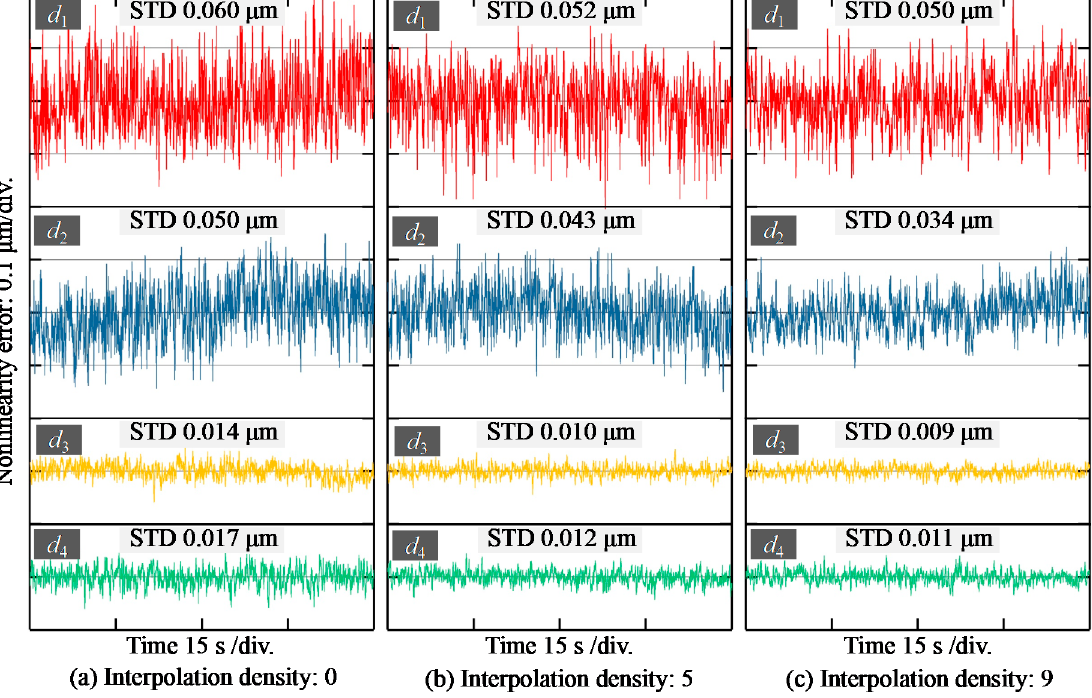
Figure 7. Stability at different displacements with different interpolation densities ( d 1 = 30 μ m, d 2 = 220 μ m, d 3 = 360 μ m, d 4 = 390 μ m).